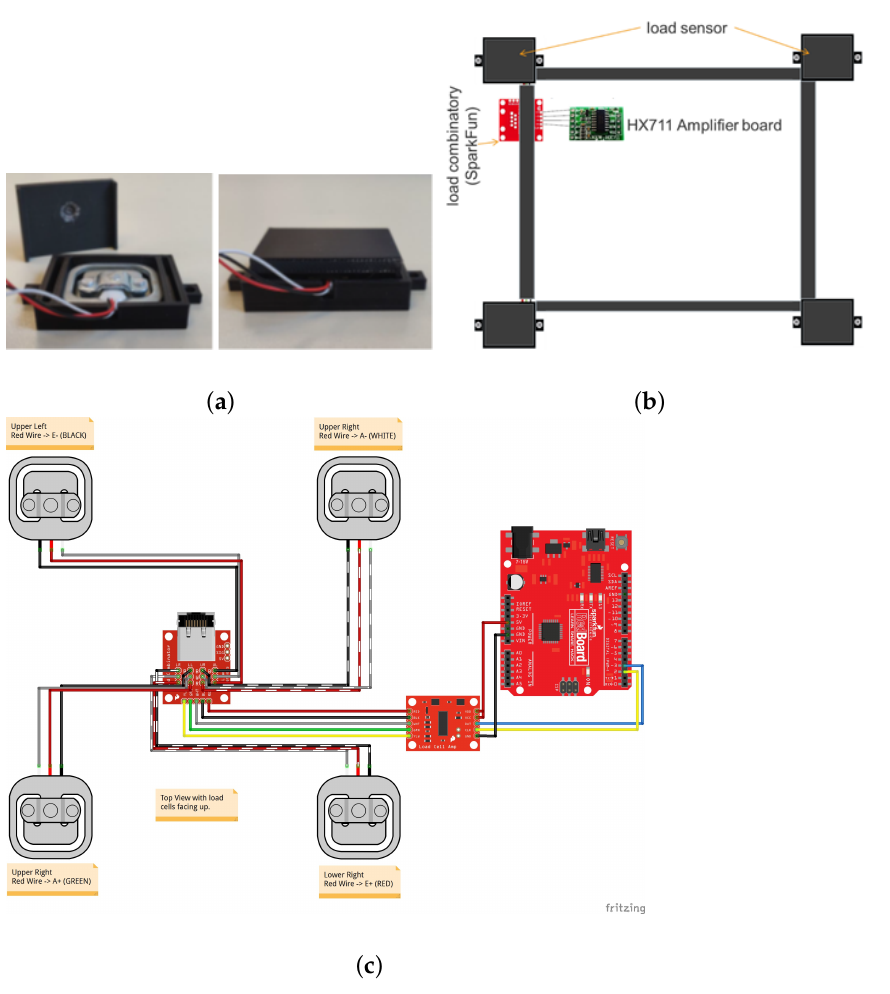
Figure 10. Weight sensor: ( a ) single strain gauge, ( b ) a load sensor combinator from sparkfun, ( c ) Wheatstone bridge configuration c https://learn.sparkfun.com/tutorials/load-cell-amplifier-